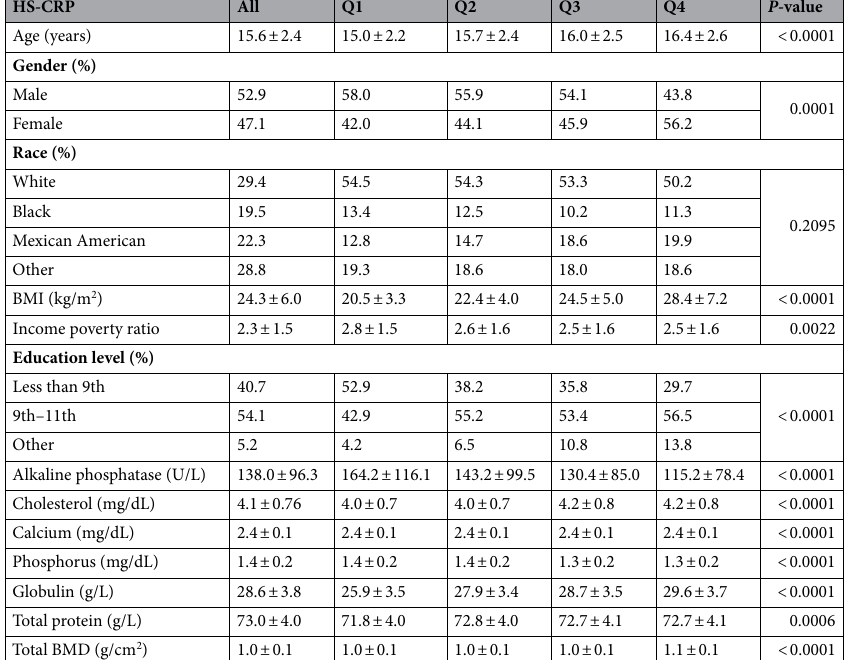
Table 1. Description of 1747 participants included in the present study. Mean ± SD for continuous variables: P value was calculated by one-way ANOVA (normal distribution) and Kruskal–Wallis H (skewed distribution) test % for categorical variables: P value was calculated by chi-square